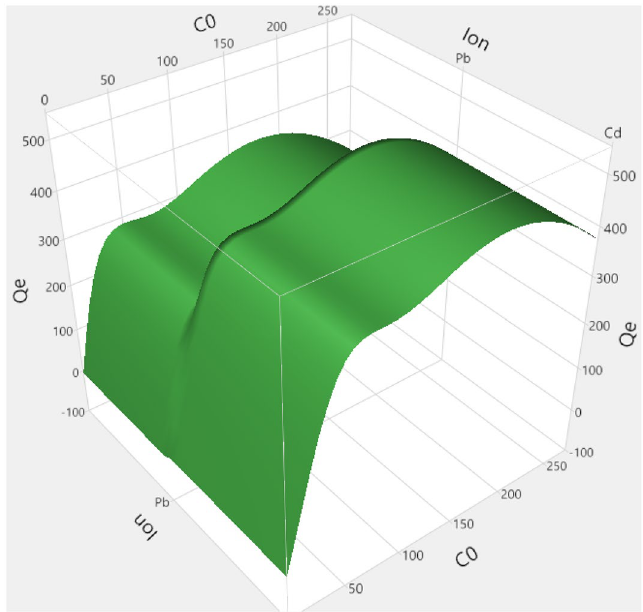
Figure 4. 3D plot of predicted Qe.